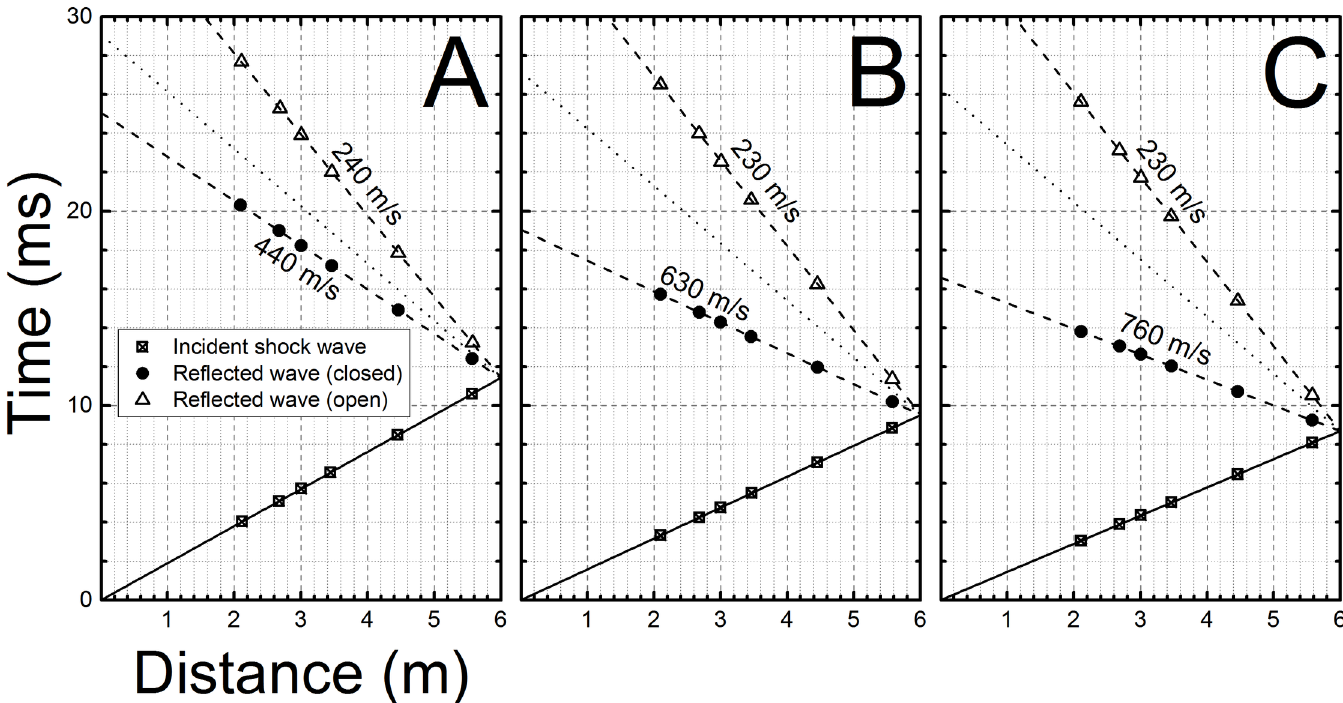
Fig 9. The distance-time (x-t) diagrams for incident and reflected waves based on experimental arrival times obtained at membrane thicknesses of: A) 0.02, B) 0.04, and C) 0.06 inches, respectively. The traces representing reflected waves are from experiments when the tube was fully closed and the underpressure waves observed when no endplate was present. Speed of sound for reflected wave domain is marked as dotted